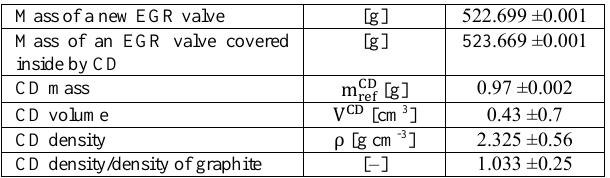
Table 1. The masses of EGR valve without an electric drive for two cases: the new valve and the one covered inside with CDs, the CD mass, CD volume and CD density, the ratio of CD density and that of